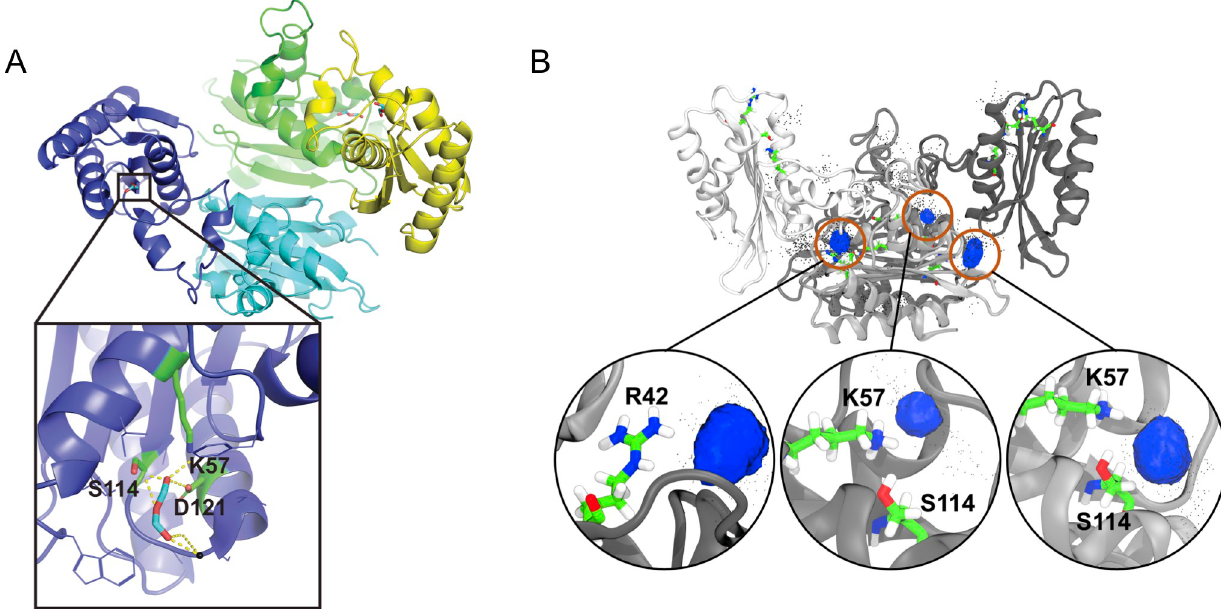
Fig 6. X-ray crystal structure of EfgA and predicted formaldehyde binding sites. (A) EfgA tetramer with each chain highlighted in different colors. Inset: enlarged view of the EfgA binding pocket showing 3 crucial amino acids, K57, D121, and S114, potentially involved in H-bond interaction with formaldehyde in the crystal structure. (B) EfgA tetramer with each chain highlighted in shades of gray with all 2,020 docked poses of formaldehyde and two key amino acids, K57 and S114. Each pose is represented by a single carbon atom (black points) of formaldehyde. Blue clusters demonstrate highly populated regions. Orange circles show an enlarged view of each distinct site. Residues at each site are elementally color-coded, with carbon = green, oxygen = red, nitrogen = blue, and hydrogen = white.